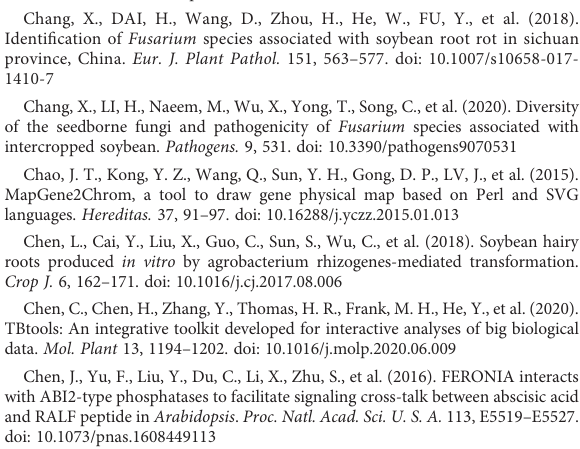
SUPPLEMENTARY FIGURE 5 Amino acid sequencealignment analysis of GmRALFs involved in regulating immuneresponse. (A) Aminoacidsequencesof fi veGmRALFsthatpositively regulatetheimmune response. (B) Amino acid sequencesofnine GmRALFs